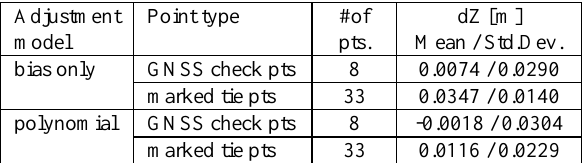
Table 1. Vertical quality of LiDAR points from marker point differences.